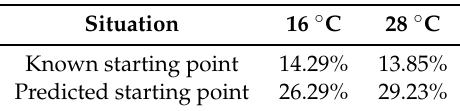
Table 2. Outlier ratio of two situations: known starting point and predicted starting point under ambient temperatures of 16 ◦ C and 28 ◦